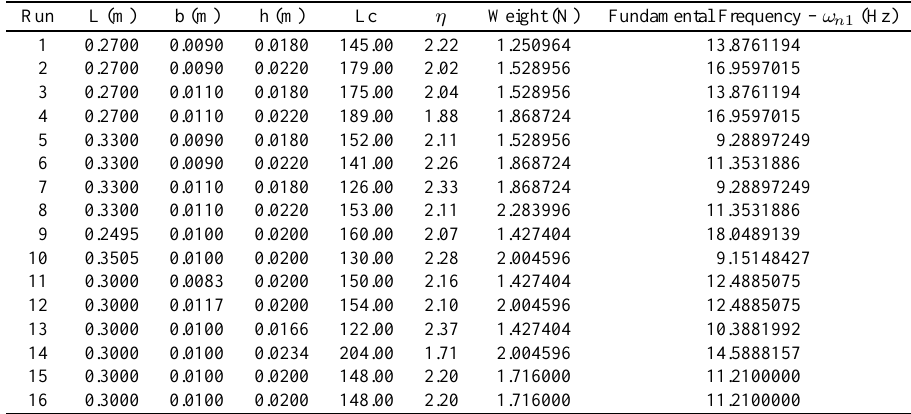
Table 3 Central composite experimental design for response surface based optimization